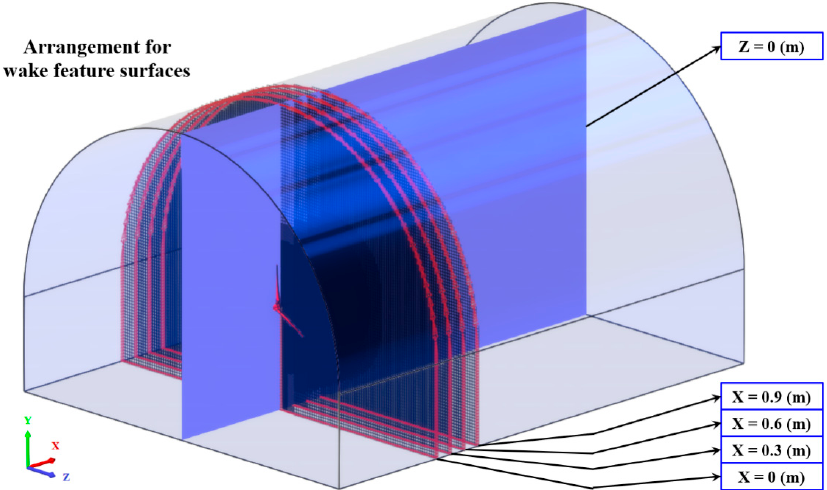
Figure 9. Feature surface arrangement in the computational model.